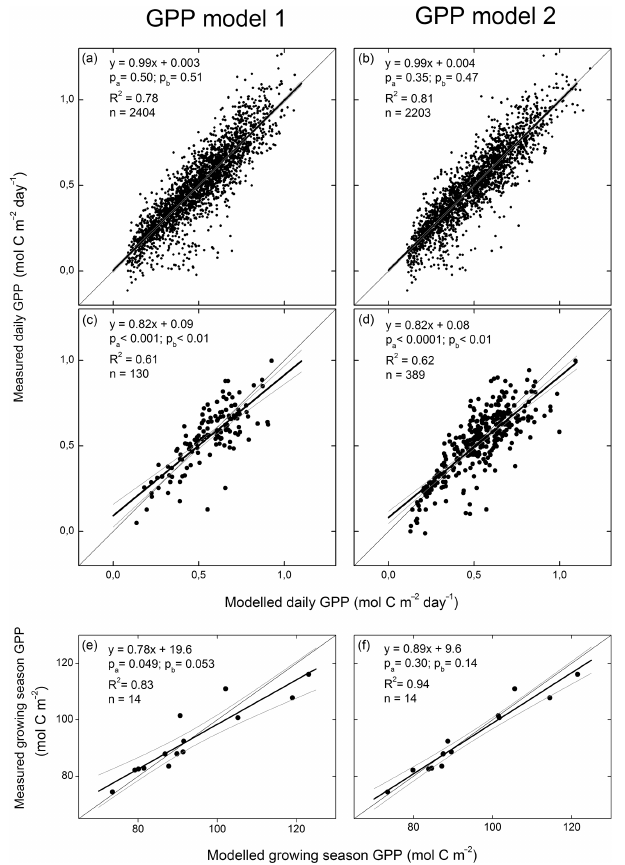
Figure 8. The measured versus the modelled gross primary produc- tivity (GPP) for days used for model training and testing (a, b) , for days on which an O 3 effect was assumed (c, d) , and for the entire growing season (e, f) . GPP model 1 was trained without days with the highest stomatal O 3 uptake, whereas GPP model 2 was trained to test for possible lag effects of O 3 on GPP. The black lines are the fitted linear regression lines and the grey lines mark the 95% confi- dence bands. Also shown are the p values for the tests of the slope and intercept from the regression y = ax + b being different from 1 and 0, respectively.